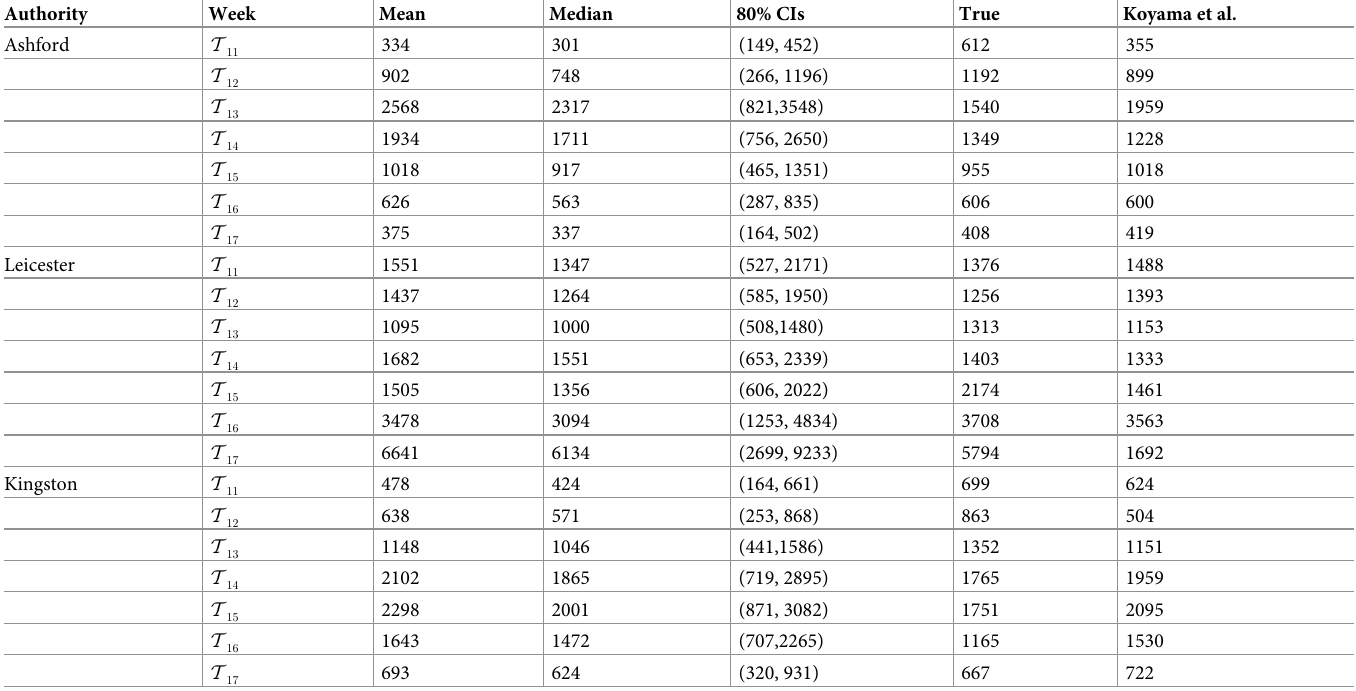
Table 4. The true number of infections in T the predicted infections given by the method of Koyama et al. [10] using a rolling-window analysis in local authorities. Authority